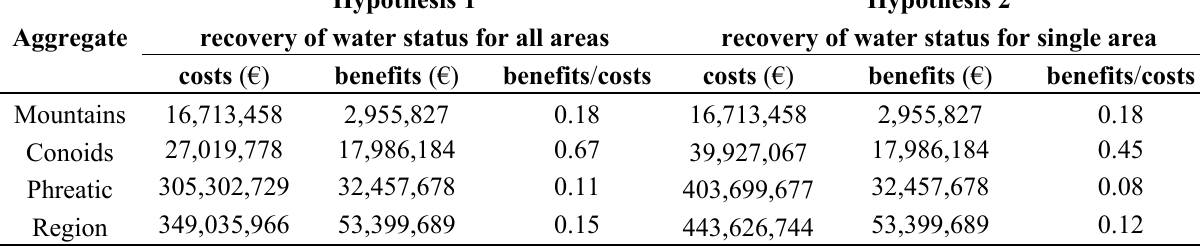
Table 6. Cost and benefit estimation for both surface and groundwater at the level of aggregation of groundwater